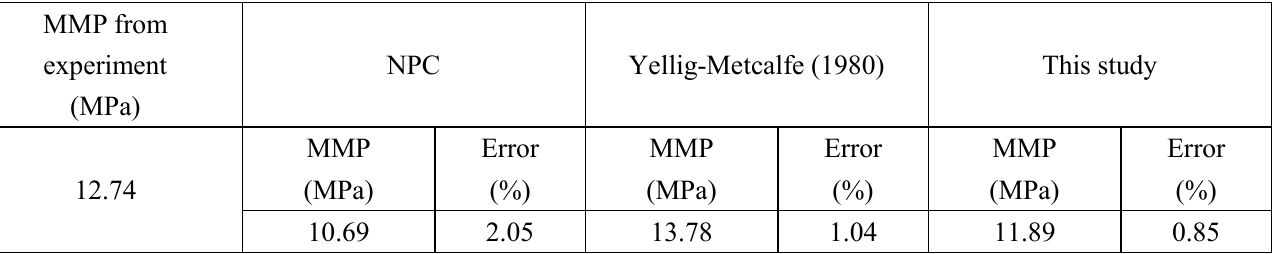
Table 2 — Comparisons between the proposed method and the empirical